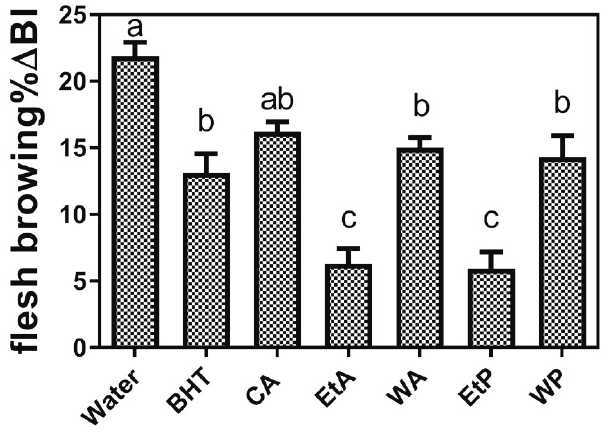
Fig. 3 ­ Short­time test: effect of dipping on flesh browning of fresh­cut apples. Δ Browning Index (ΔBI) percentage determined at 20°C, after 3 hours from dipping treat­ ments: water; BHT (1% butylated hydroxytoluene); CA (1% citric acid); EtA (10% ethanol apple extract); WA (water apple extract); EtP (10% ethanol potato extract); WP (water potato extract). Data are means ±